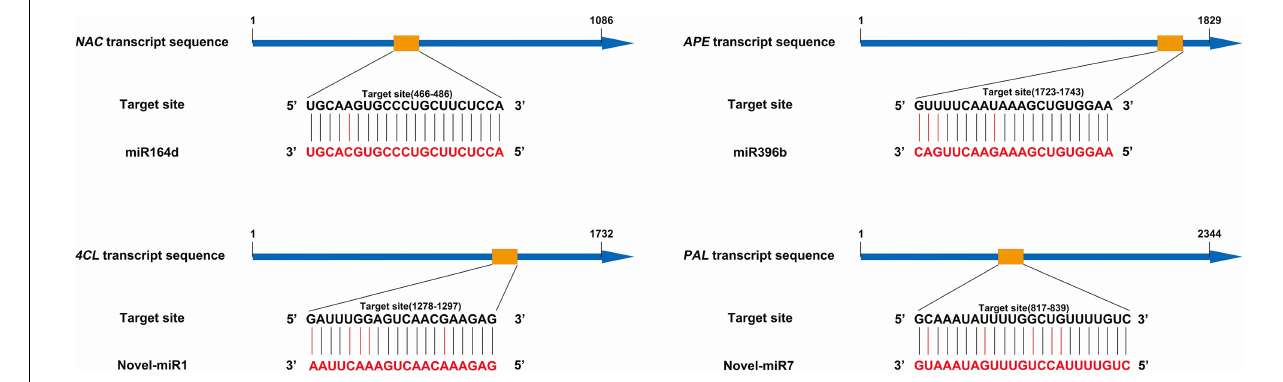
FIGURE 1 | Target sites of candidate miRNAs.